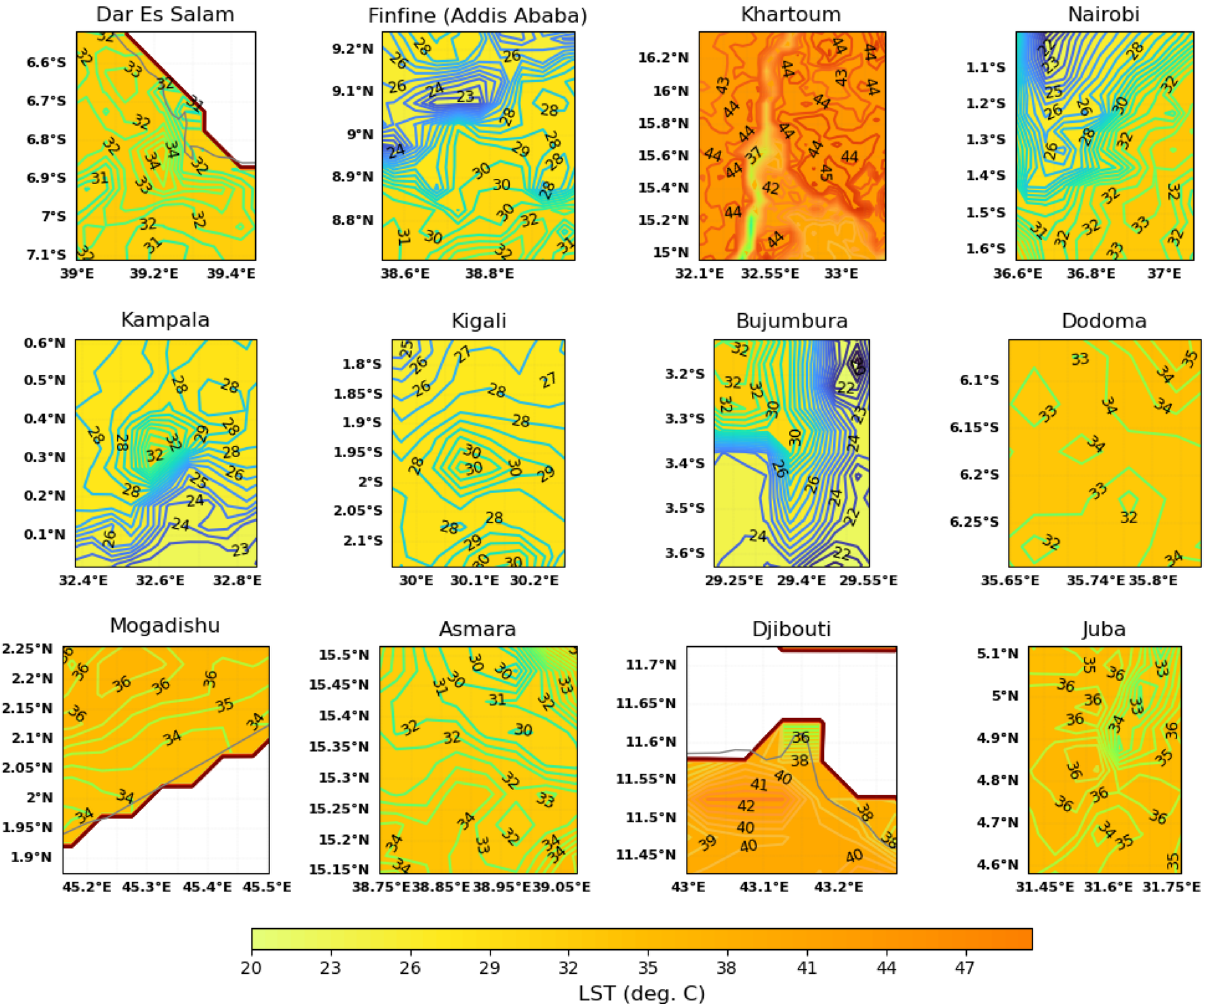
Figure 4. Land surface temperature around the capital cities in the greater horn of Africa urban area temperature and compare it with the surface temperature in the rural areas surrounding the capital cities, to understand the intensity of the TSUHIs. This is explained in the next section. Temporal TSUHIs. The area averaged monthly mean of the urban heat islands show the seasonal intensity of the tropical surface urban heat islands (Fig. 6). The seasonal urban heat island characteristics is inhomogeneous across the cities in the greater horn of Africa region. Most of the cities have shown to have high intensity TSUHI from late summer to winter. The cities with high TSUHI in late summer and early autumn, that is August-Sep- tember-October-November (ASON) are Kampala, Addis Ababa, Juba and Kigali (red lines in Fig. 6); cities with late autumn and winter (Novermber-December-January-February, NDJF) are Djibouti, Dodoma and Asmara (yellow lines in Fig. 6); cities with non-seasonal urban heat islands are Mogadishu, Nairobi, and Daresalam (gray lines in Fig. 6). Bujumbura and Khartoum do not have positive area averaged monthly mean urban heat islands (lines with aquamarine color in Fig. 6). Of the 12 cities considered in this study 10 have shown to have positive mean area tropical surface urban heat islands. This implies that most of the cities in the greater horn of Africa do exhibit the tropical surface urban heat islands (TSUHIs). Kampala has the highest urban area average TSUHI followed by Addis Ababa which showed highly seasonal TSUHI. Khartoum is the only city with the area aver- aged tropical surface urban cool islands (TSUCI). Even though, Khartoum has a highest ( ≈ 8 ◦ C) tropical sur- face urban heat islands (TSUHIs) considering the spatial analyses as shown in “Spatial TSUHIs” Section , where ◦ ◦ the land surface temperature is 37 C near the Nile river and 45 C further away from the river horizontally (Fig. 4), the area average monthly mean TSUHI is negative, swinging around − 1 ◦ C (Fig. 6). This is because the maximum temperature values away from the Nile river cancel out the minimum temperature values around the river, hence the mean area TSUHI for Khartoum is almost negligible. This shows that, for some urban areas, the mean area values of the urban heat islands do not give accurate representation of the intensity of the urban heat islands. Nonetheless, it provides an estimation of how much the urban area contributes to a regional warming. The night time TSUHI is lower than the day time TSUHI (compare Figs. 6 and 7). During the night, eight of the 12 cities (Addis Ababa, Bujumbura, Daresalam, Kigali, Mogadishu, Juba, Kampala, Nairobi) have TSUHI